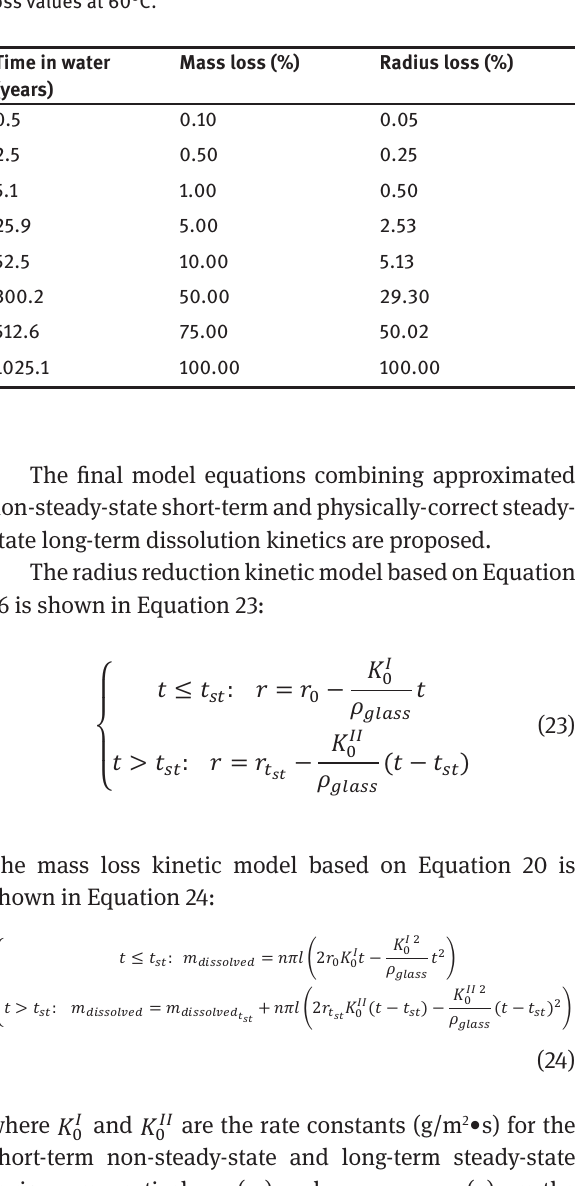
Table 3: Predicted dissolution times for various mass and radius loss values at